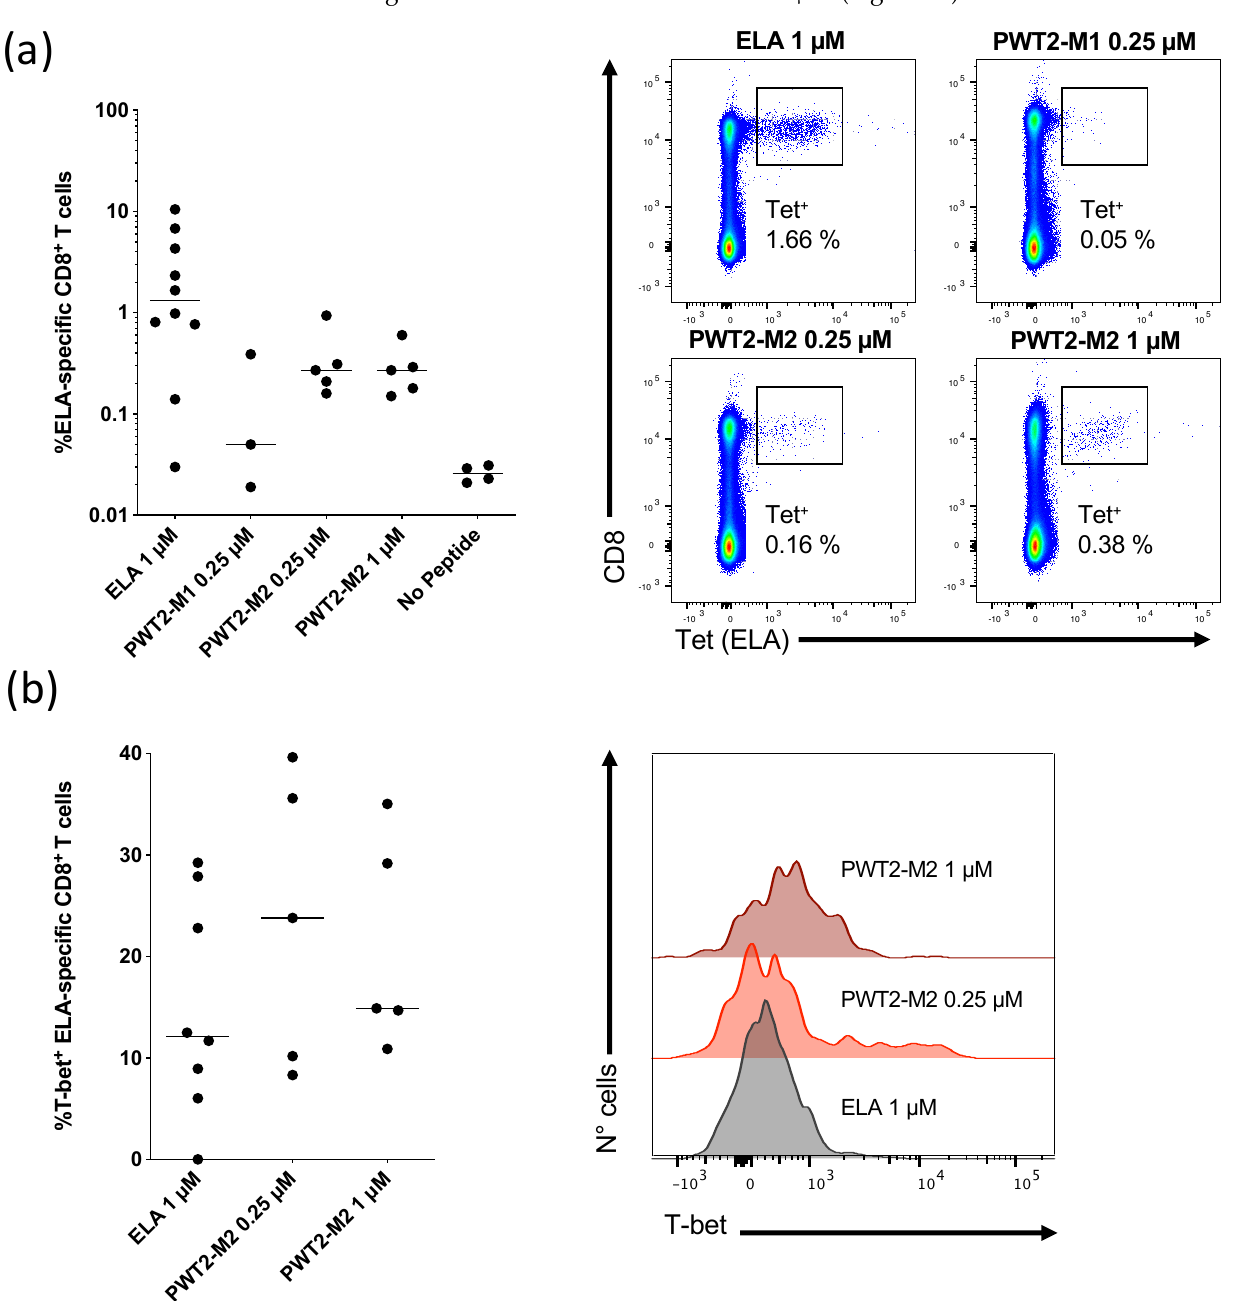
Figure 2. In vitro priming of human naive CD8 + T cells specific for a melanoma-associated epitope conjugated to PWT2 (PWT2-M1 and PWT2-M2). ( a ) Data summary (left panel) and representative flow cytometry plots (right panel) showing tetramer + ELA-specific CD8 + T cells expanded in the presence of Flt3 ligand, a cocktail of cytokines (TNF, IL-1 β , IL-7, and PGE2), and the ELA peptide, either alone or conjugated to PWT2. PBMCs primed in the absence of peptide (PWT2 alone) were used as a negative control. ( b ) Data summary (left panel) and representative flow cytometry histogram plots (right panel) showing intracellular expression of T-bet among the corresponding tetramer + ELA-specific CD8 + T cells. Left panels: each dot represents one HLA-A2 + donor per condition, and horizontal bars indicate median values ( a , b ). Right panels: plots are gated on viable CD3 + events ( a ) or on tetramer + ELA-specific CD8 + T cells ( b ). Significance was determined using the two-tailed Mann–Whitney U test with Bonferroni correction for multiple